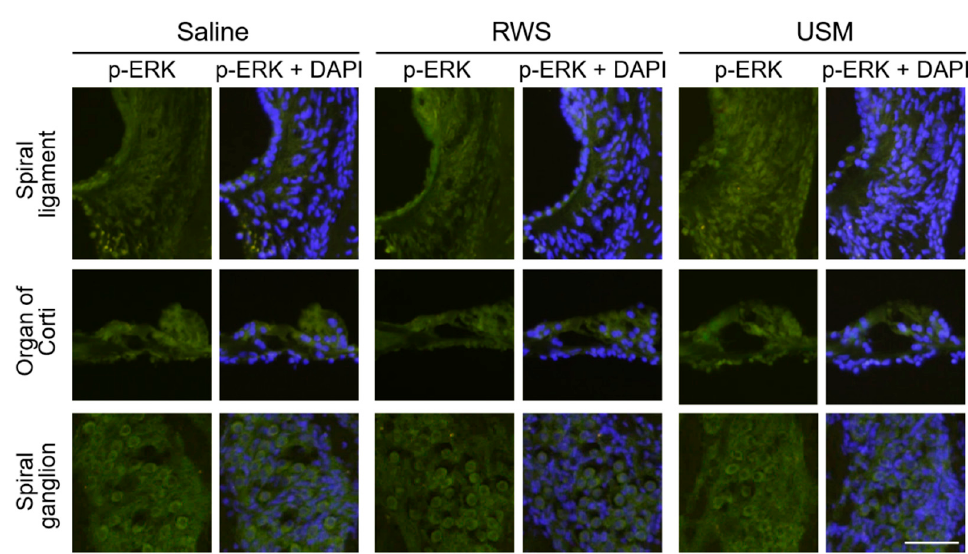
Figure 7. Immunohistochemical staining for p-ERK 1/2 in a cryosection of the cochlea after noise exposure and different treatments. The combination of ultrasound microbubbles and IGF-1 (USM group), IGF-1 only (RWS group) or saline only (saline group) was administered 24 h after noise exposure. The samples were collected 2 h after treatment. Immunofluorescence staining showing p-ERK immunostaining (green) and nuclei (blue, DAPI). This experiment was repeated four times. Scale bars = 100 µm. IGF-1, insulin-like growth factor-1; DAPI = 4,6-diamidino-2-phenylindole; USM, ultrasound microbubble; RWS, round window soaking.